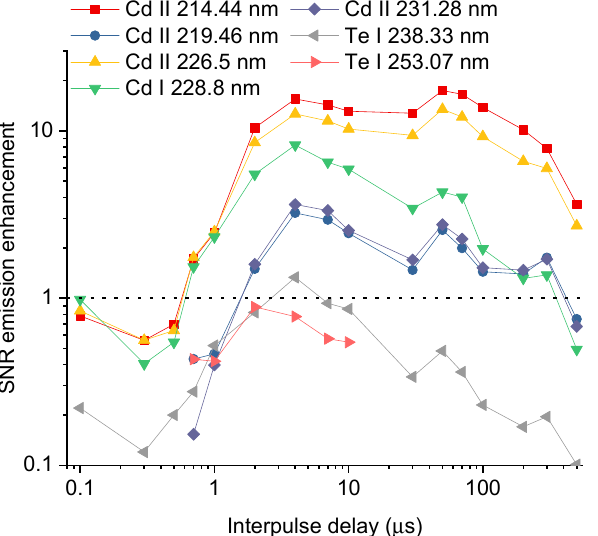
Figure 3. Signal-to-noise emission intensification for the orthogonal reheating double-pulse experiment as a function of the interpulse delay. The ICCD acquisition delay is 700 ns after the second pulse and the gate width is 30 µs.